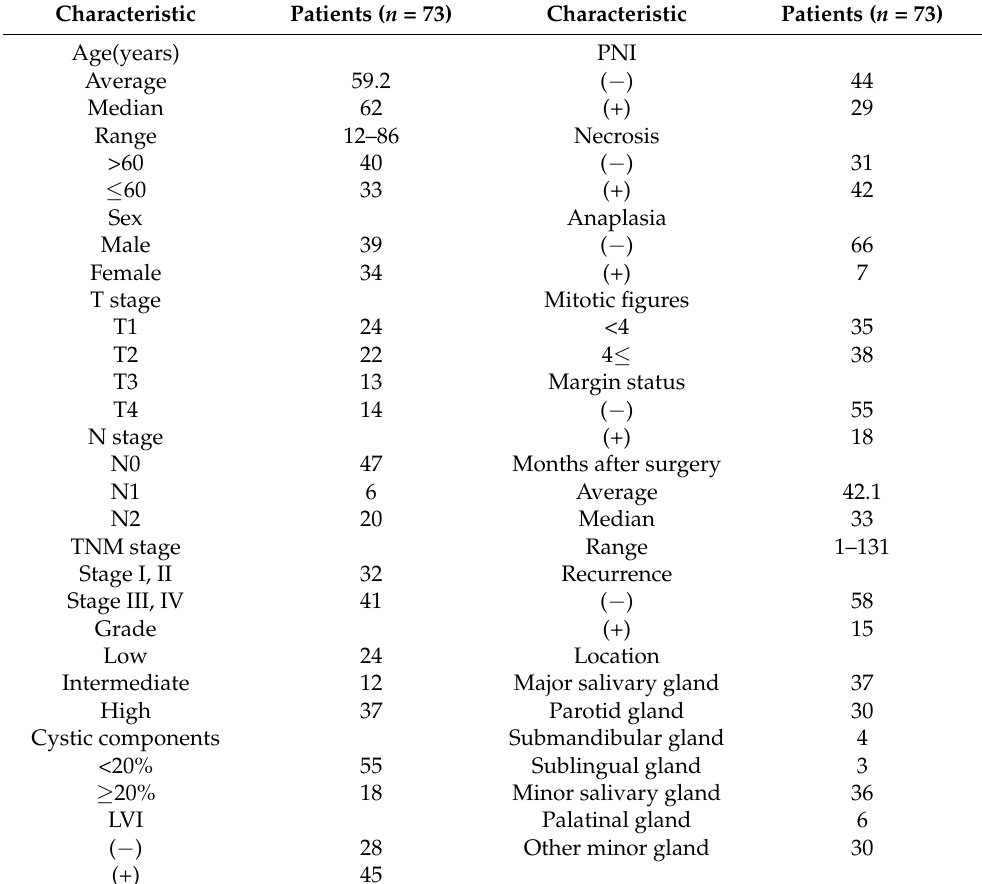
Table 1. Clinicopathological variables of all MEC